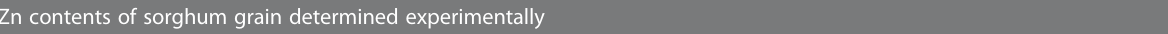
TABLE 2 Estimation of daily dietary recommendation for Zn in sorghum grain using agronomic forti fi cation under drought stress growth condition (adapted from ref 39). Zn contents of sorghum grain determined experimentally Sorghum plant +